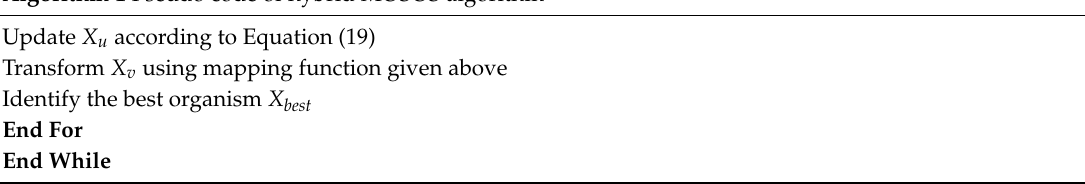
Algorithm 1 Pseudo code of hybrid MOSOS